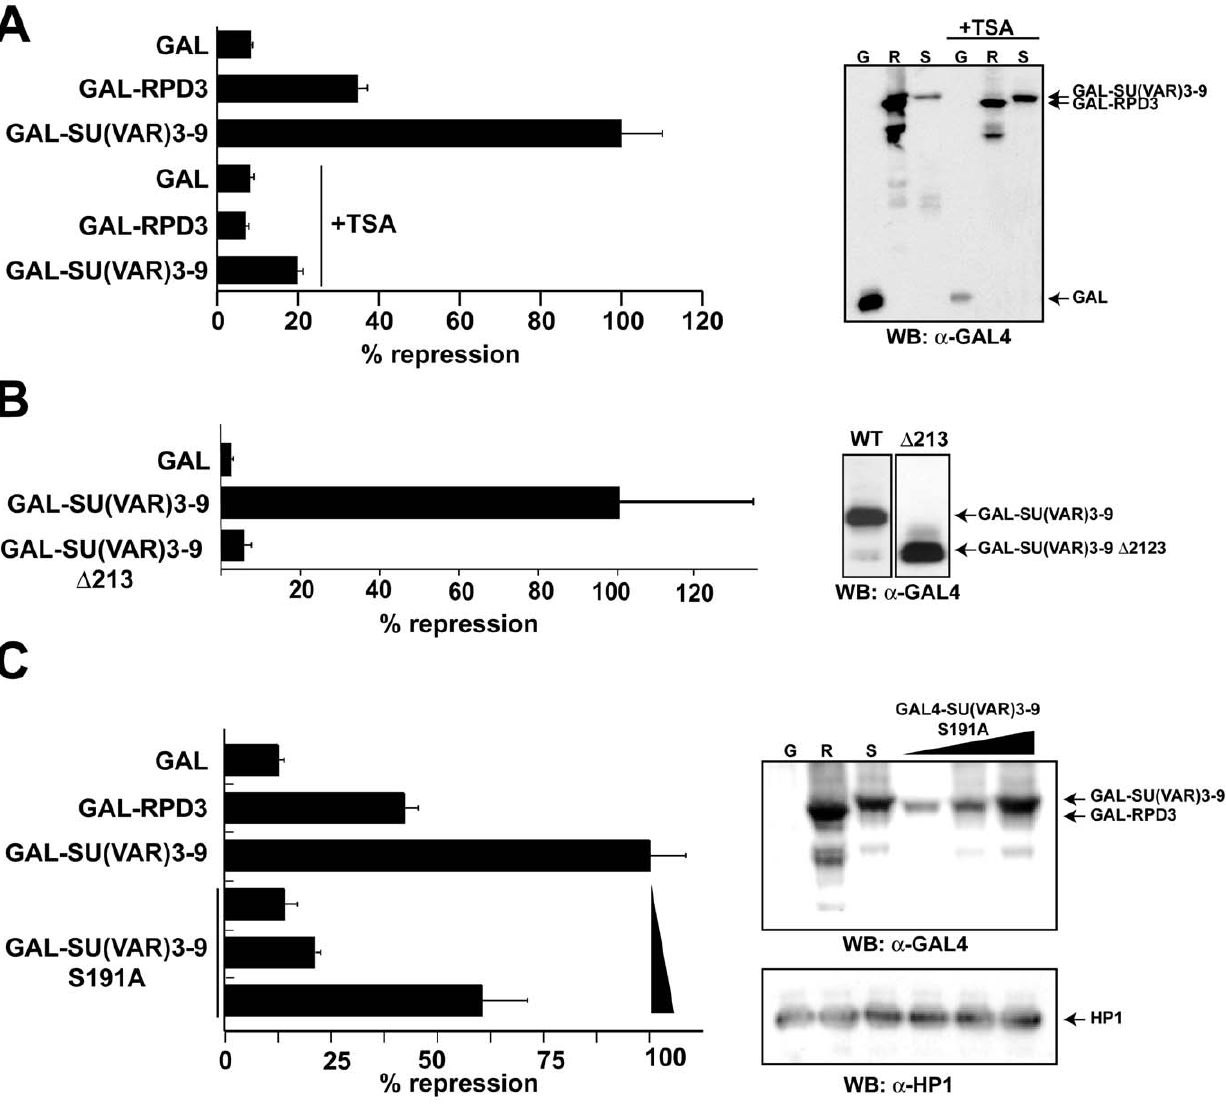
Figure 4. SU(VAR)3–9 can repress transcription when tethered to a promoter. ( A ) SU(VAR)3–9 represses transcription in a TSA-dependent manner. ( B ) An N-terminal truncation of SU(VAR)3–9 lacking the domain that interacts with JIL-1 and RPD3 can no longer repress transcription. ( C ) SU(VAR)3–9’s transcriptional repression capacity is 2 fold reduced in a S191A mutated SU(VAR)3–9. Drosophila SL2 cells were co-transfected with expression constructs for dorsal and twist and the reporter construct pG 5 DE 5 -tkluc together with the indicated plasmids coding for: GAL4-DBD or GAL4 fusion proteins of SU(VAR)3–9 (and deletions/mutations thereof) and RPD3 in the presence or absence of the histone deacetylase inhibitor trichostatin A (TSA). left: luciferase assay of the activated reporter gene after transfection with the indicated plasmids. The repression capacity of GAL4-SU(VAR)3–9 was set to 100% and all other values were normalized accordingly. right : Western Blot analysis of the extracts used for the luciferase assay using an antibody specific against the GAL4-DBD [G: GAL4 DBD; R: GAL4-Rpd3; S: GAL4- SU(VAR)3–9].